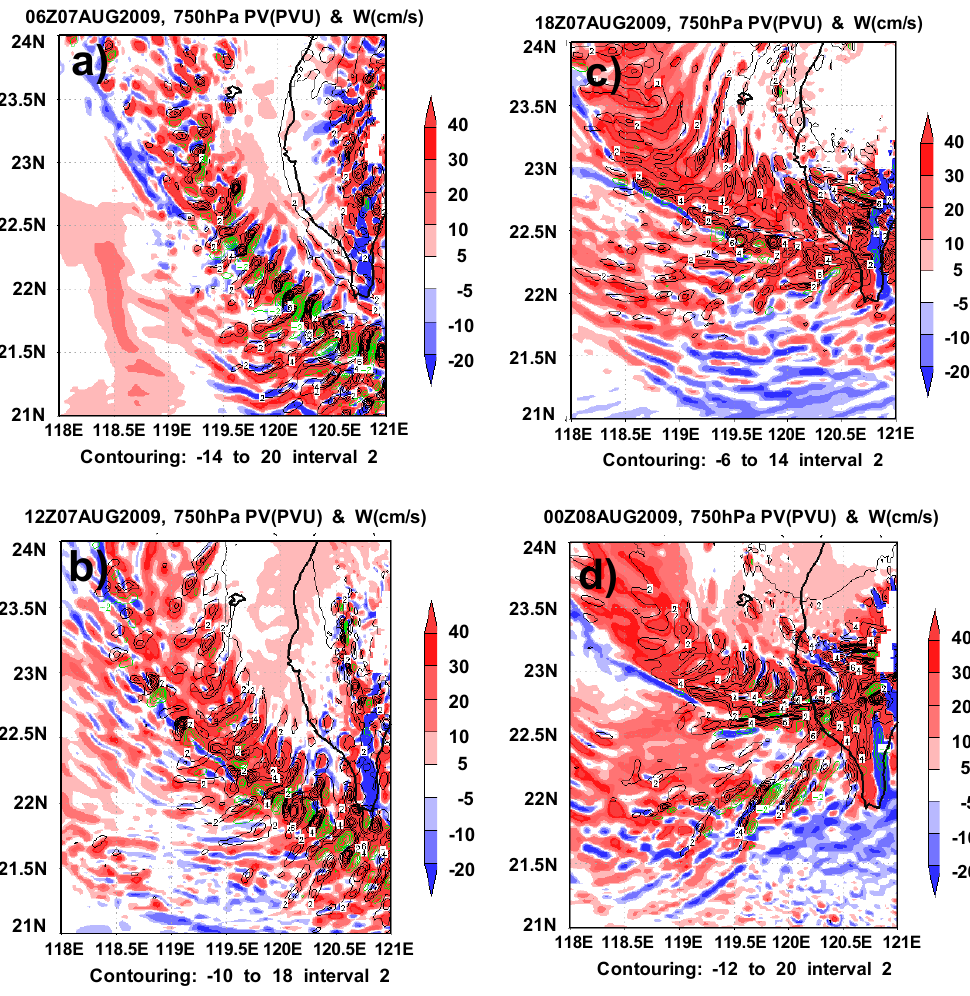
Fig. 7. Simulation of vertical velocity fields (colored shades: positive in red and negative in blue) and potential vorticity (contours: positive in black and negative in green, interval: 2PVU) at 750hPa for (a) 06:00UTC 7 August (b) , 12:00UTC 7 August (c) 18:00UTC 7 August and (d) 00:00UTC 8